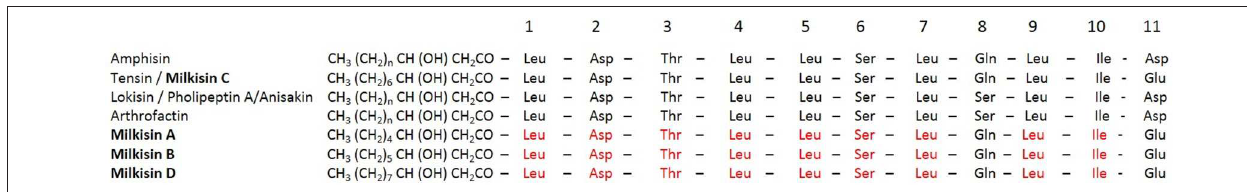
FIGURE 8 | Alignment of lipopeptide milkisin isoforms produced by Pseudomonas sp. UCMA 17988 with members of amphisin group.